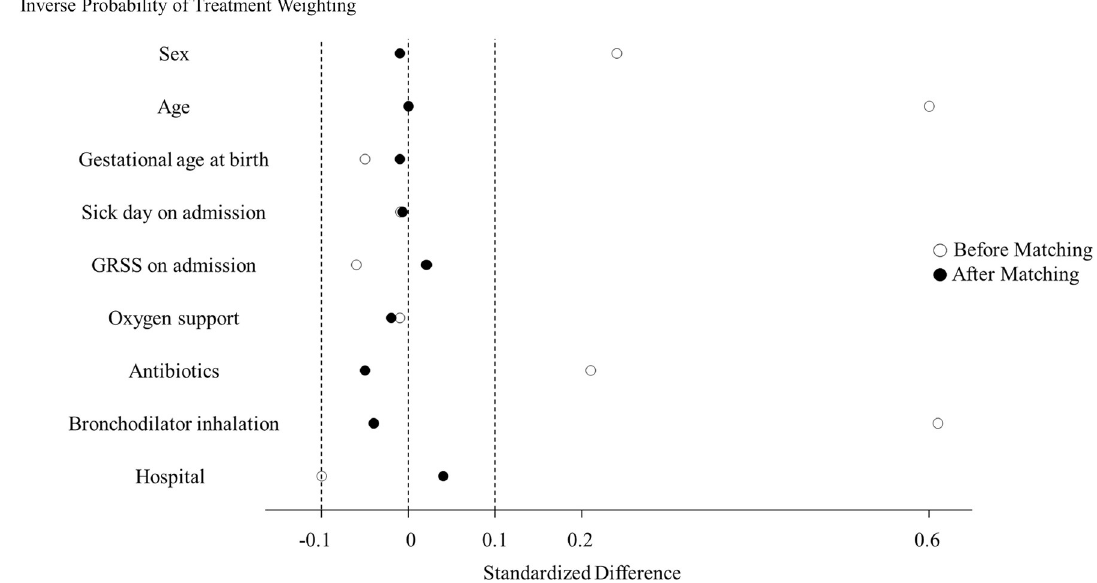
Fig 4. Covariate balance for inverse probability of treatment weighting of infants treated with and without pranlukast.